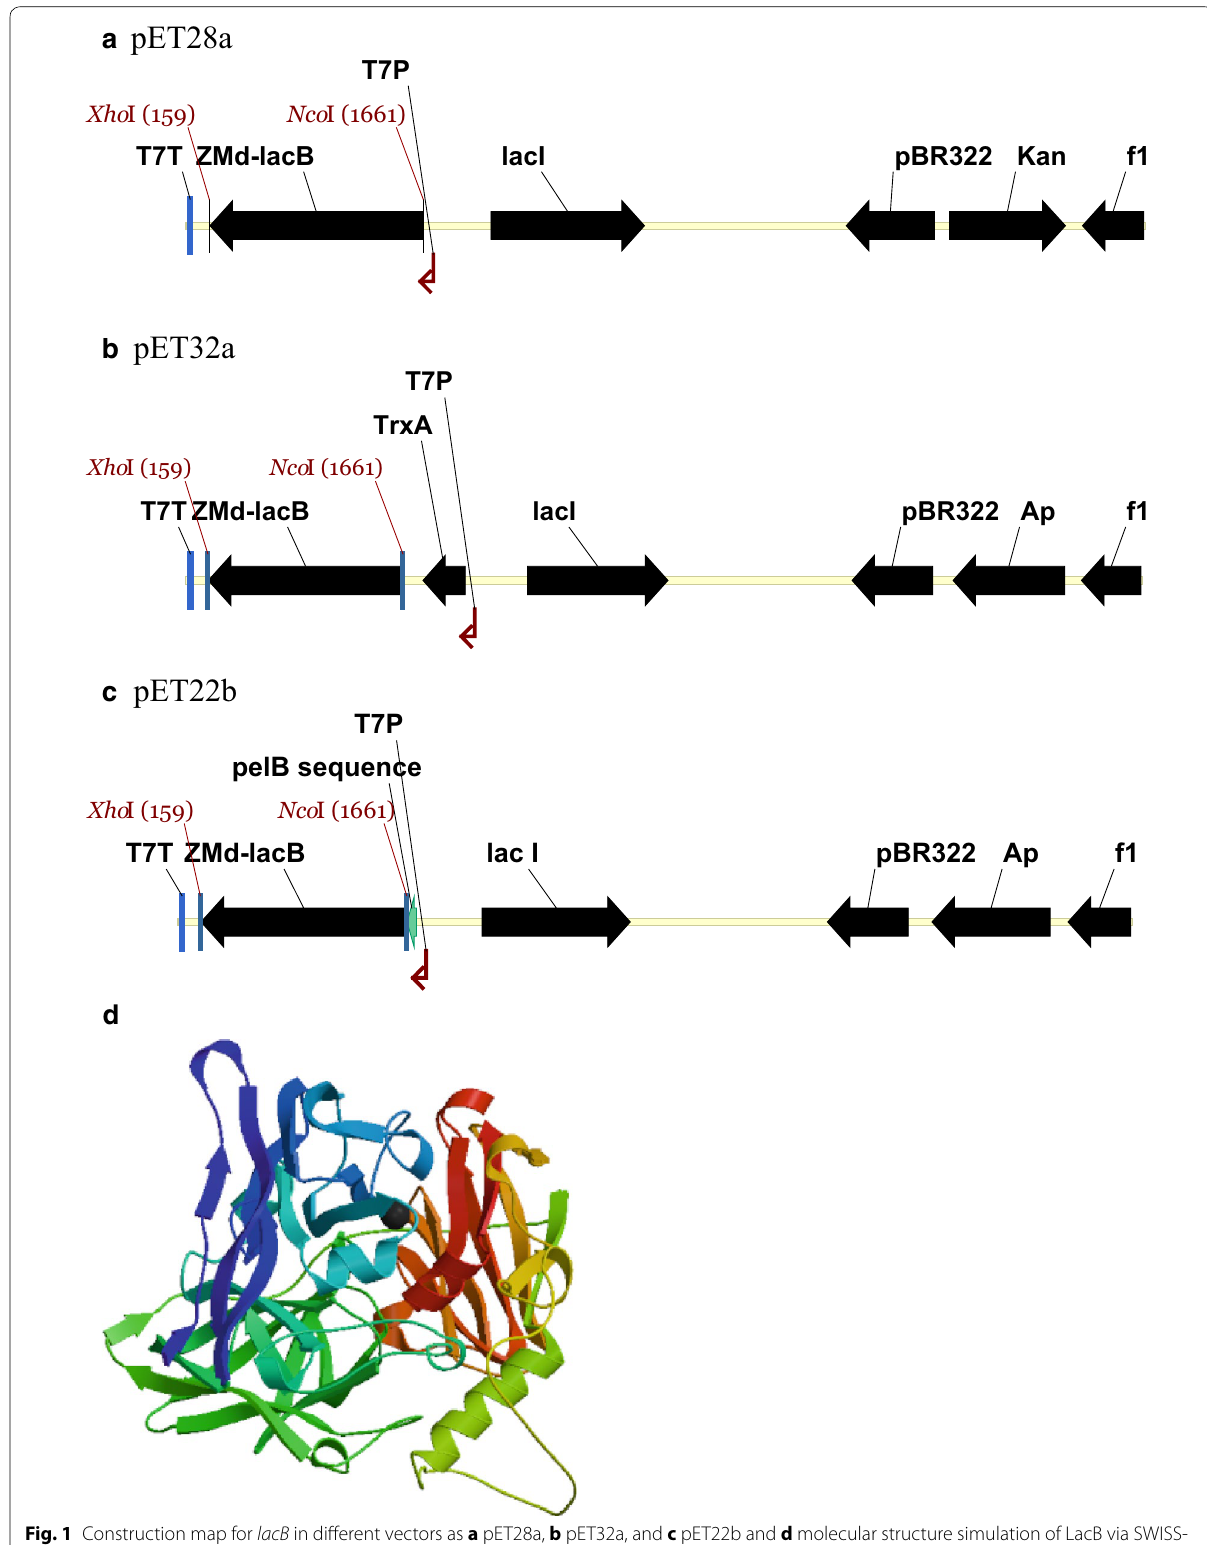
Fig. 1 Construction map for lacB in different vectors as a pET28a, b pET32a, and c pET22b and d molecular structure simulation of LacB via SWISS‑